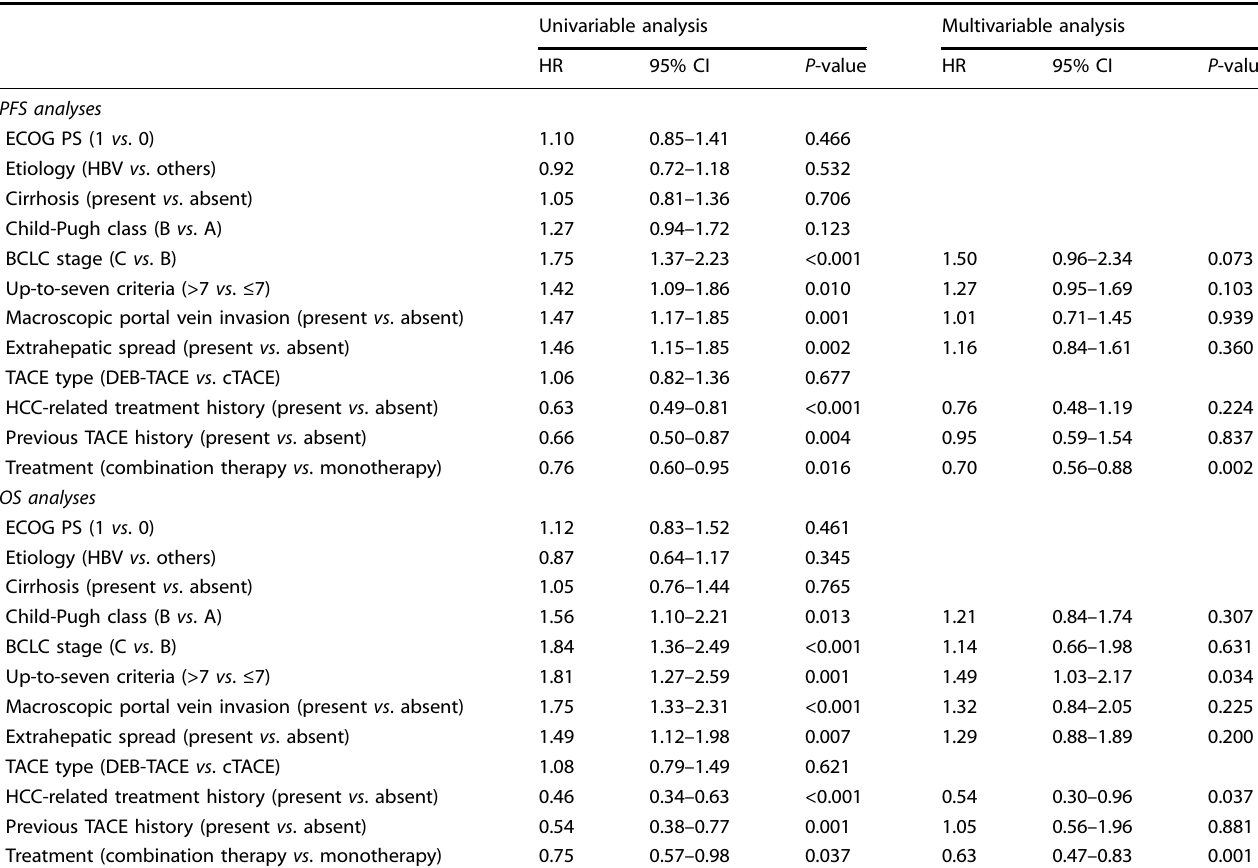
Table 2. Predictors of progression-free survival and overall survival after matching